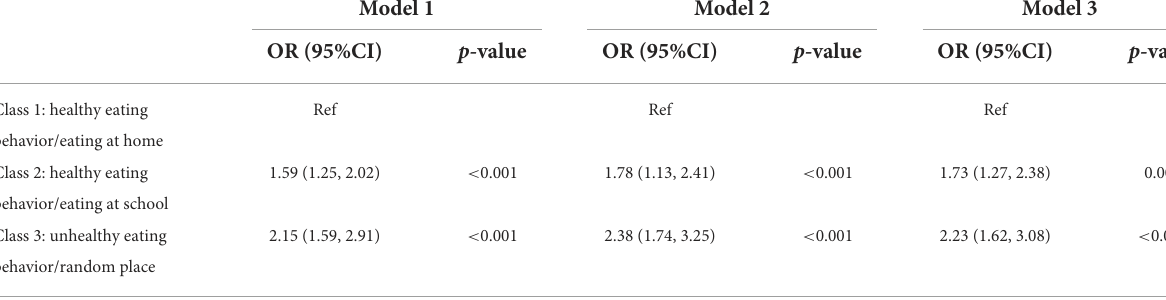
TABLE 6 Association between latent class membership and mental health